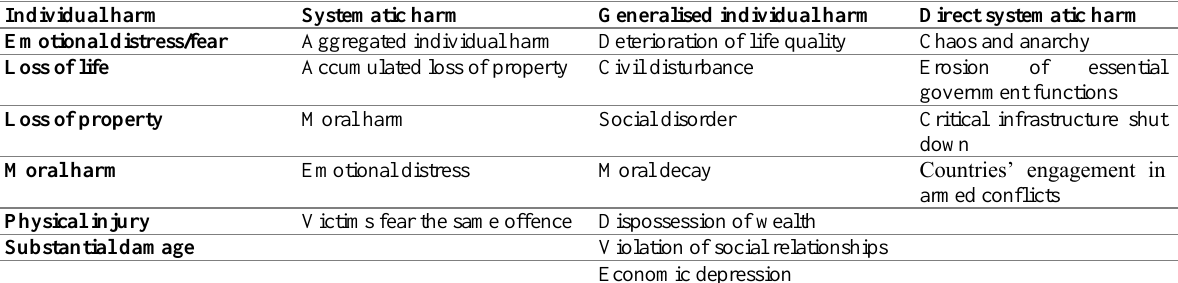
Table 1: Harm inflicted and disruption caused by